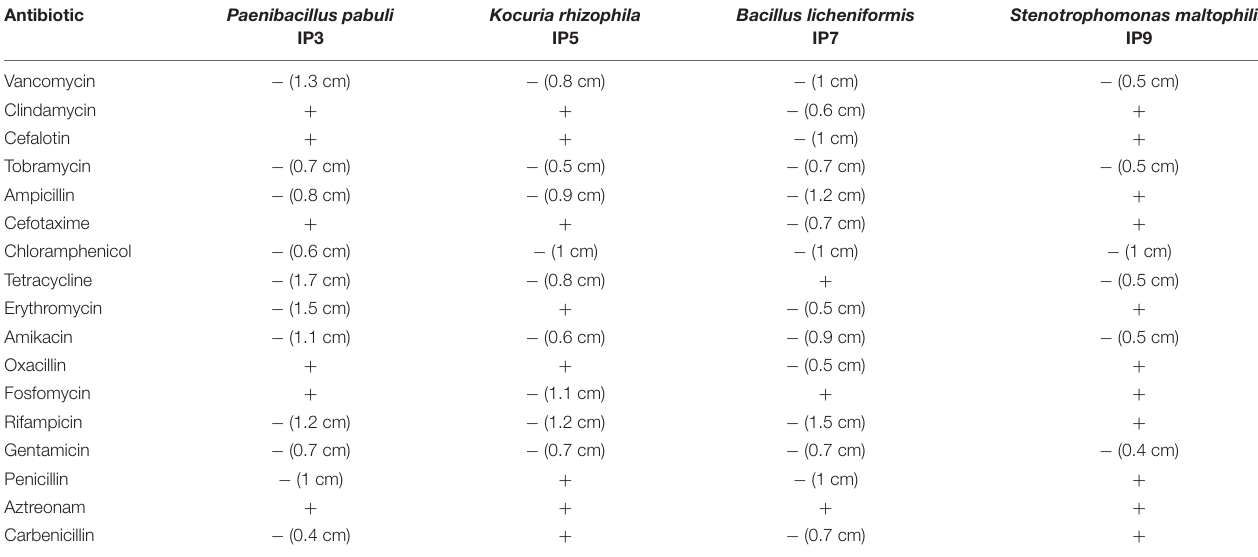
TABLE 2 | Antibiotic susceptibility of the four different bacterial strains.